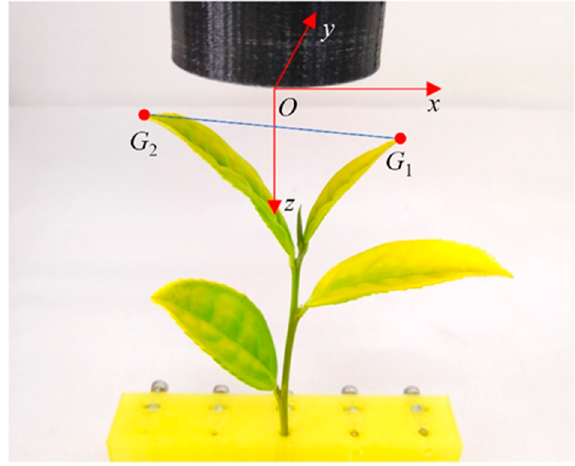
Figure 13. Diagram of tea placement.